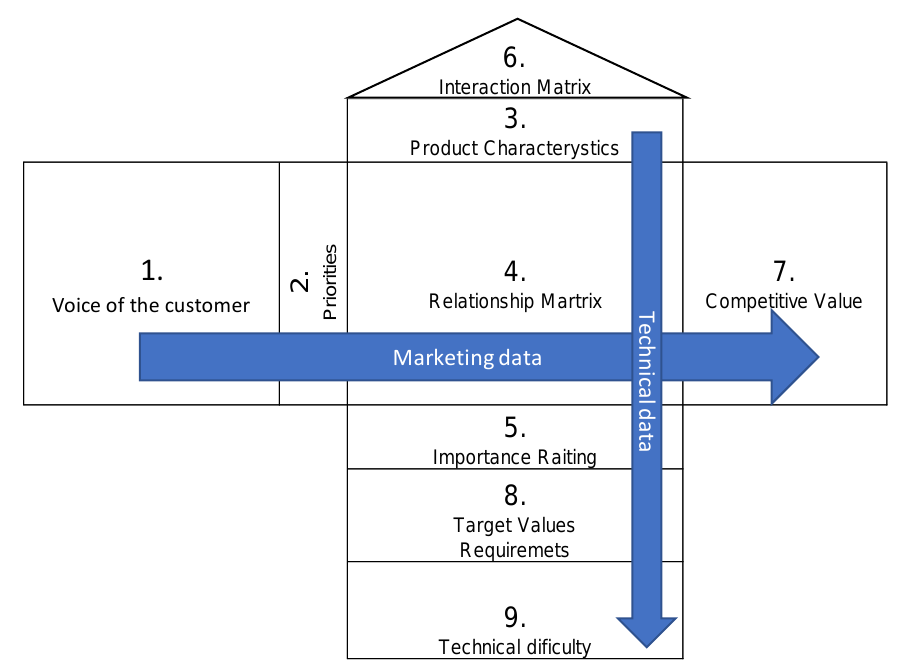
Figure 1. House of Quality building phases.